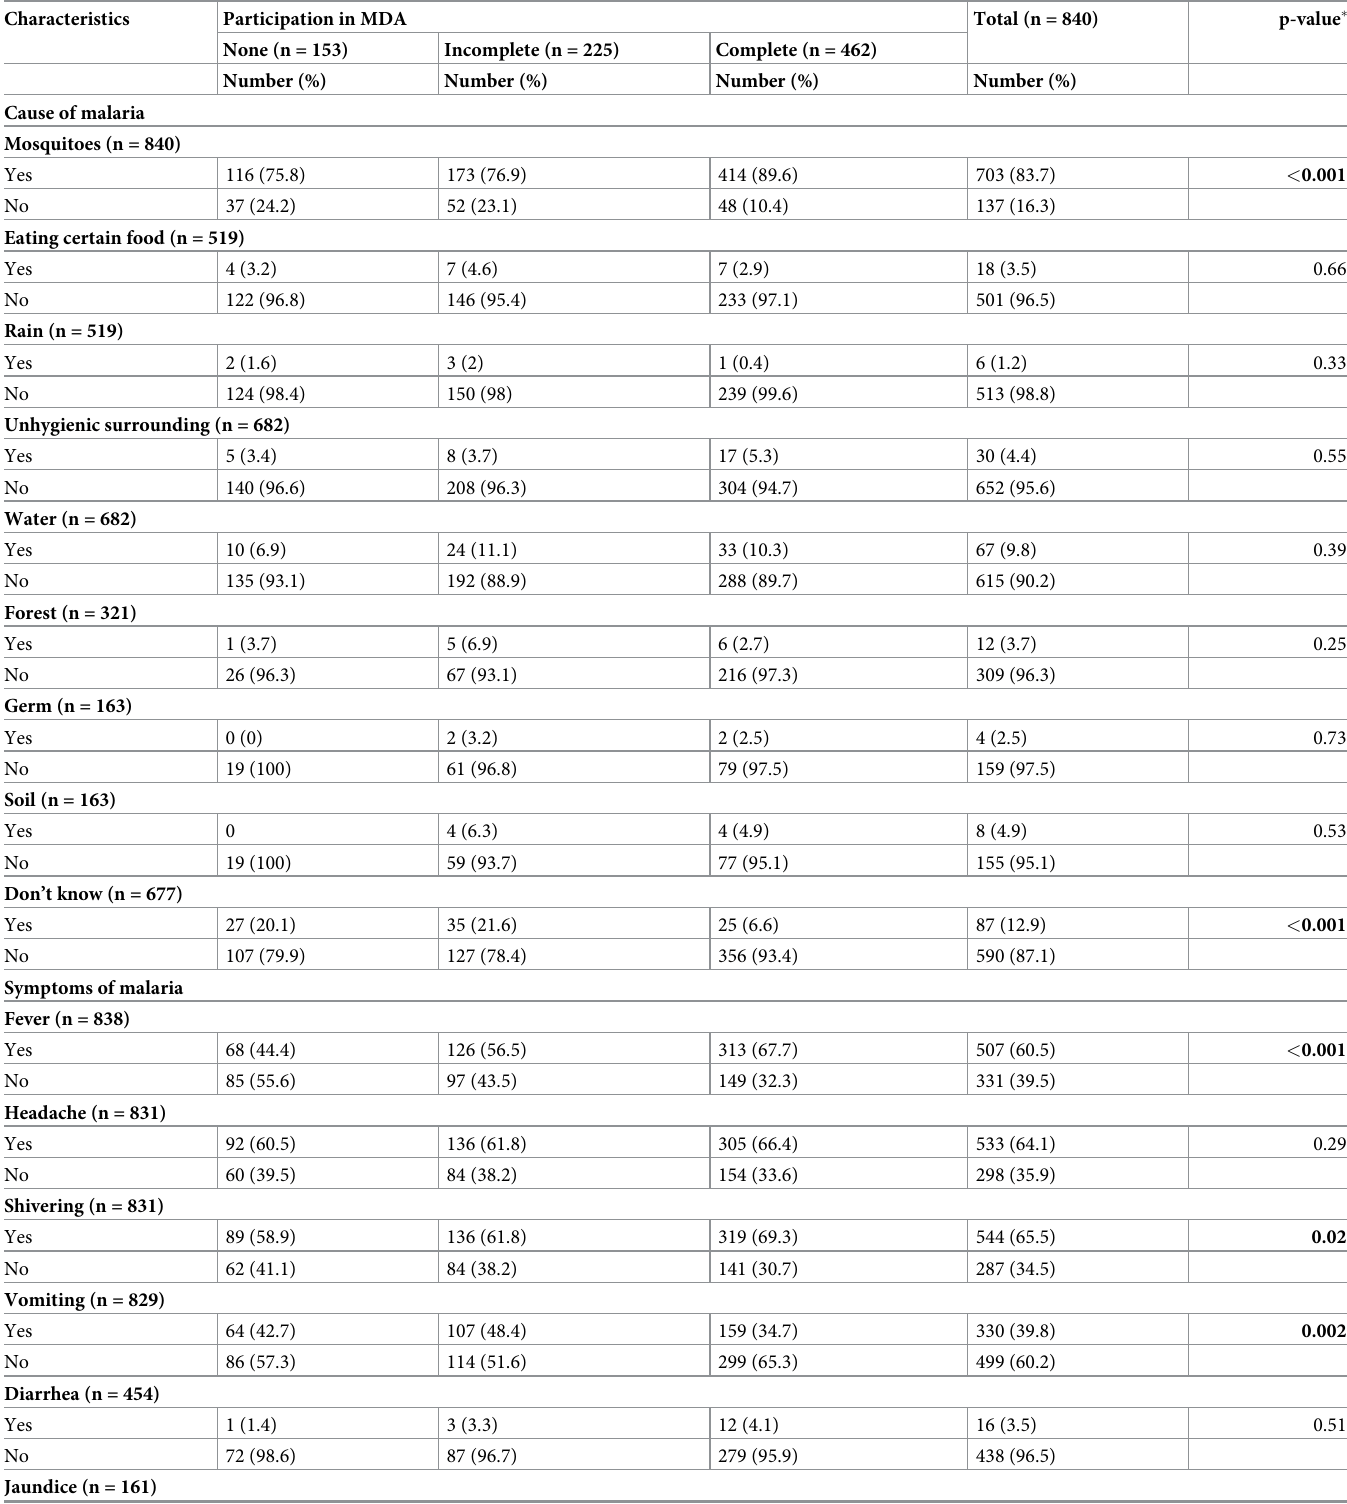
Table 5. Knowledge about malaria in relation to participation in MDA rounds (n = 840).